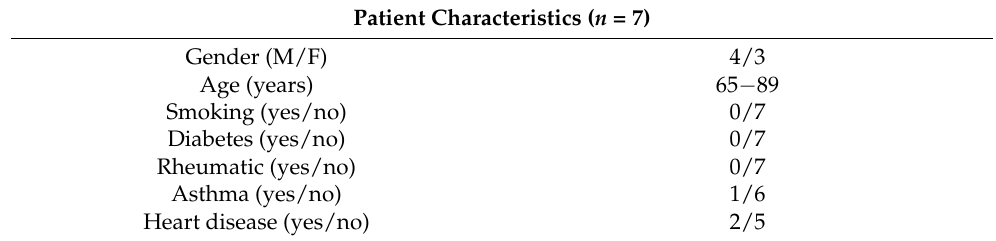
Table 1. The patient